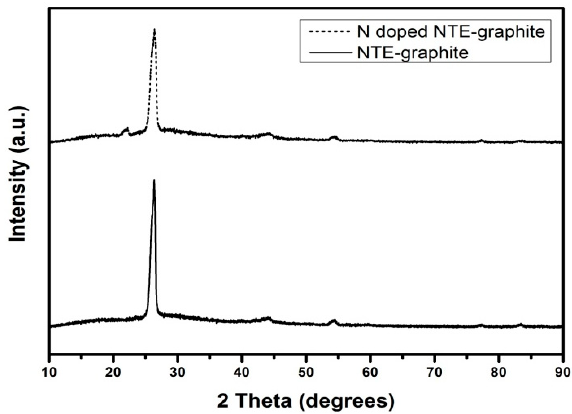
Figure 3. XRD patterns of untreated NTE graphite (solid line) and N-doped NTE graphite (dotted line).